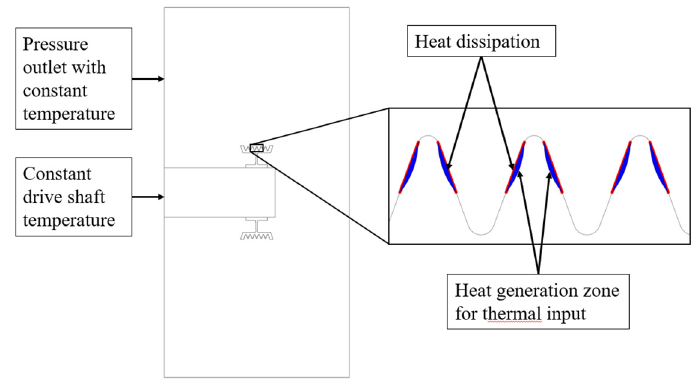
Figure 10. Boundary conditions for the numerical analysis.